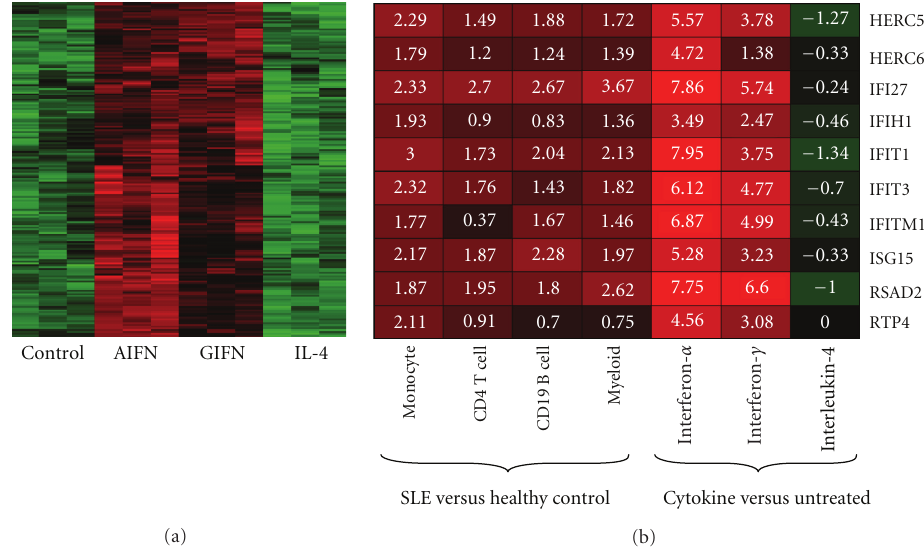
Figure 2: Cluster analysis of genes upregulated by interferons. (a) A subset of genes identified by unbiased clustering analysis were responsive to both γ IFN and α IFN, but not IL-4. On average, the expression of these genes was upregulated by 36.3% in SLE. (b) Ten focus genes identified as being upregulated in four cell types in SLE were examined in the cytokine-treated cells. These genes also exhibited increased expression after γ IFN and α IFN treatment but not IL-4